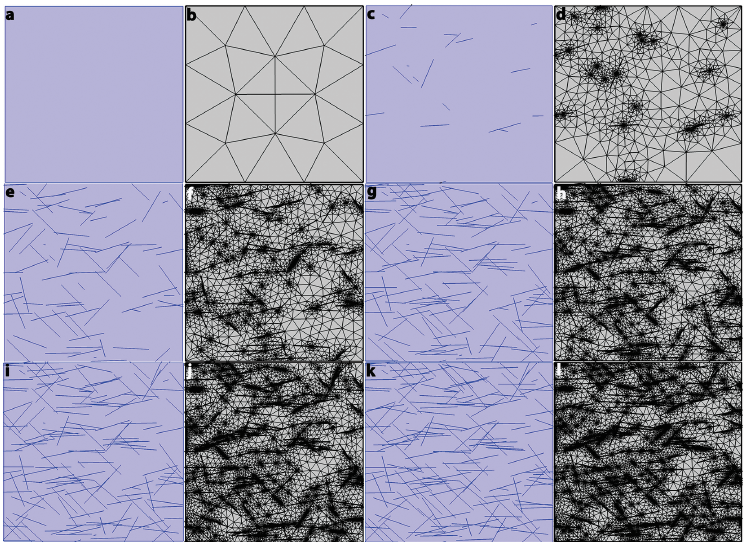
Figure 3. ( a,b ) show the random distribution of 0 CNT in the basic polymer and meshed basic polymer, respectively. ( c , d ) show the random distribution of 20 CNT in the basic polymer and meshed basic polymer, respectively. ( e , f ) show the random distribution of 80 CNT in the basic polymer and meshed basic polymer, respectively. ( g , h ) show the random distribution of 100 CNT in the basic polymer and meshed basic polymer, respectively. ( i , j ) show the random distribution of 160 CNT in the basic polymer and meshed basic polymer, respectively. ( k , l ) show the random distribution of 190 CNT in the basic polymer and meshed basic polymer, respectively. It should be noted that “20 CNT” means there is a 20 CNT particle in the basic polymer.